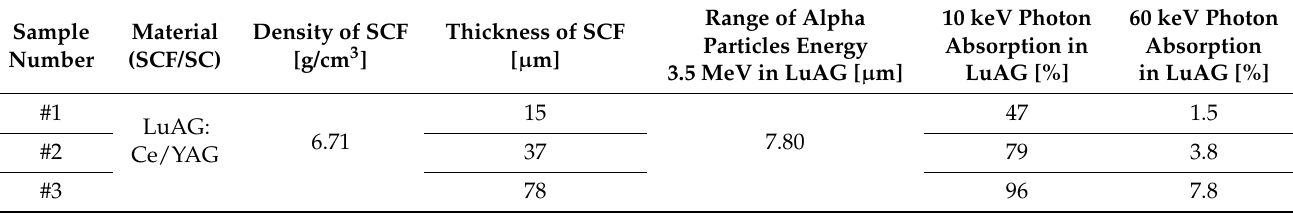
Table 1. Characteristics of the investigated SCF